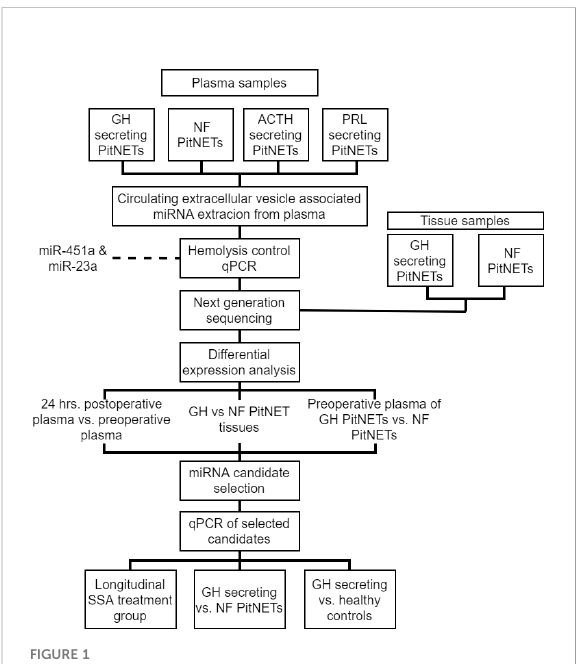
FIGURE 1 Flowchart explaining study